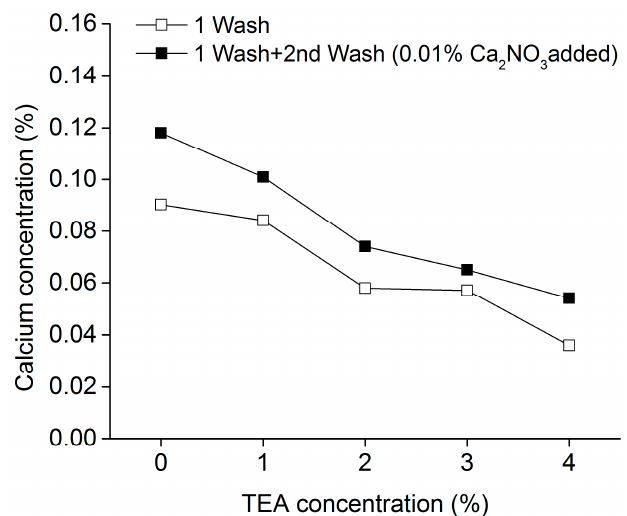
Figure 7. The calcium concentration (%) of the Nomex ® /cotton fabric treated with 12% HFPO, 3% BTCA and TEA with different concentrations, cured at 170 °C for 3 min and subjected to one regular wash followed by a second wash with 0.01% Ca(NO 3 ) 2 added.